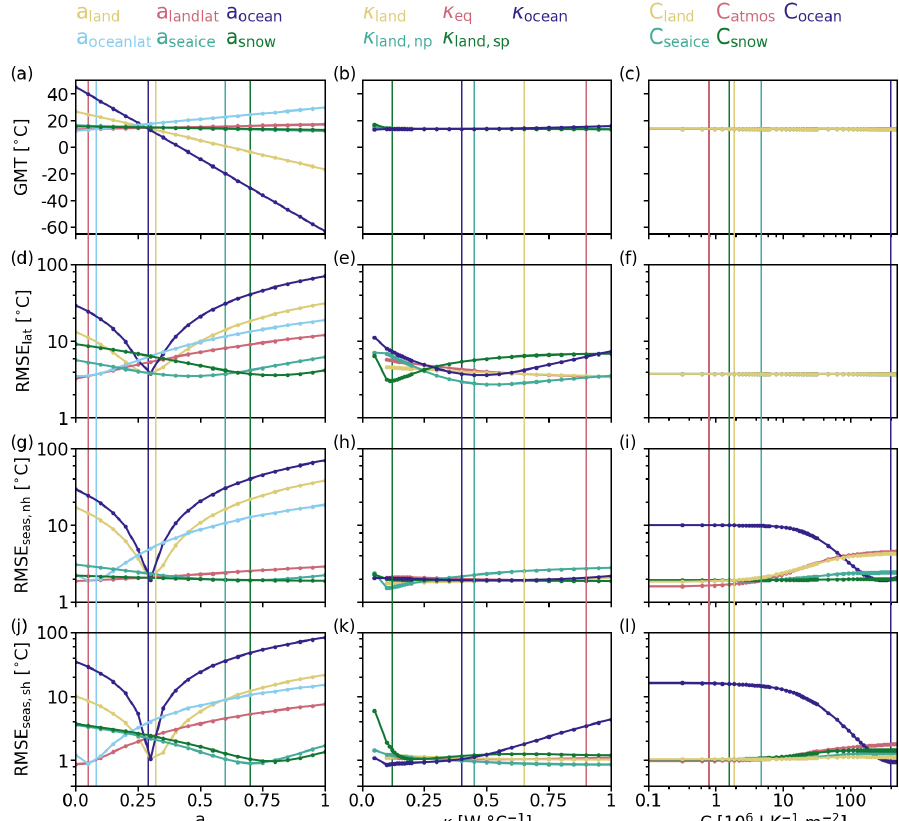
Figure 8. Effect of changes to the parameterization of albedo (first column), heat transport (second column), and heat capacity (third col- umn) on the GMT and the RMSE of the latitudinal (RMSE lat ) and seasonal temperature profiles in both hemispheres (RMSE seas , nh and RMSE seas , sh ) with respect to ERA-20CM reanalysis (Hersbach et al., 2015). (a–c) GMT, (d–f) RMSE lat , (g–i) RMSE seas , nh , and (j– l) RMSE seas , sh with all specific parameters listed at the top of each column. Simulations and reanalysis cover 1960–1989CE. The sim- ulations used the land, sea, and ice configuration shown in Fig. 1 and constant orbital parameters: eccentricity (ecc = 0 . 016740), obliquity (ob = 0 . 409253), and longitude of perihelion (per = 1 . 796257). CO 2 followed Köhler et al. (2017), and S 0 values followed Coddington et al. (2016). Vertical lines indicate the chosen values after tuning. Albedo affects all tuning metrics, while thermal conductivities barely change GMT and heat capacities only manipulate the seasonal temperature distributions.